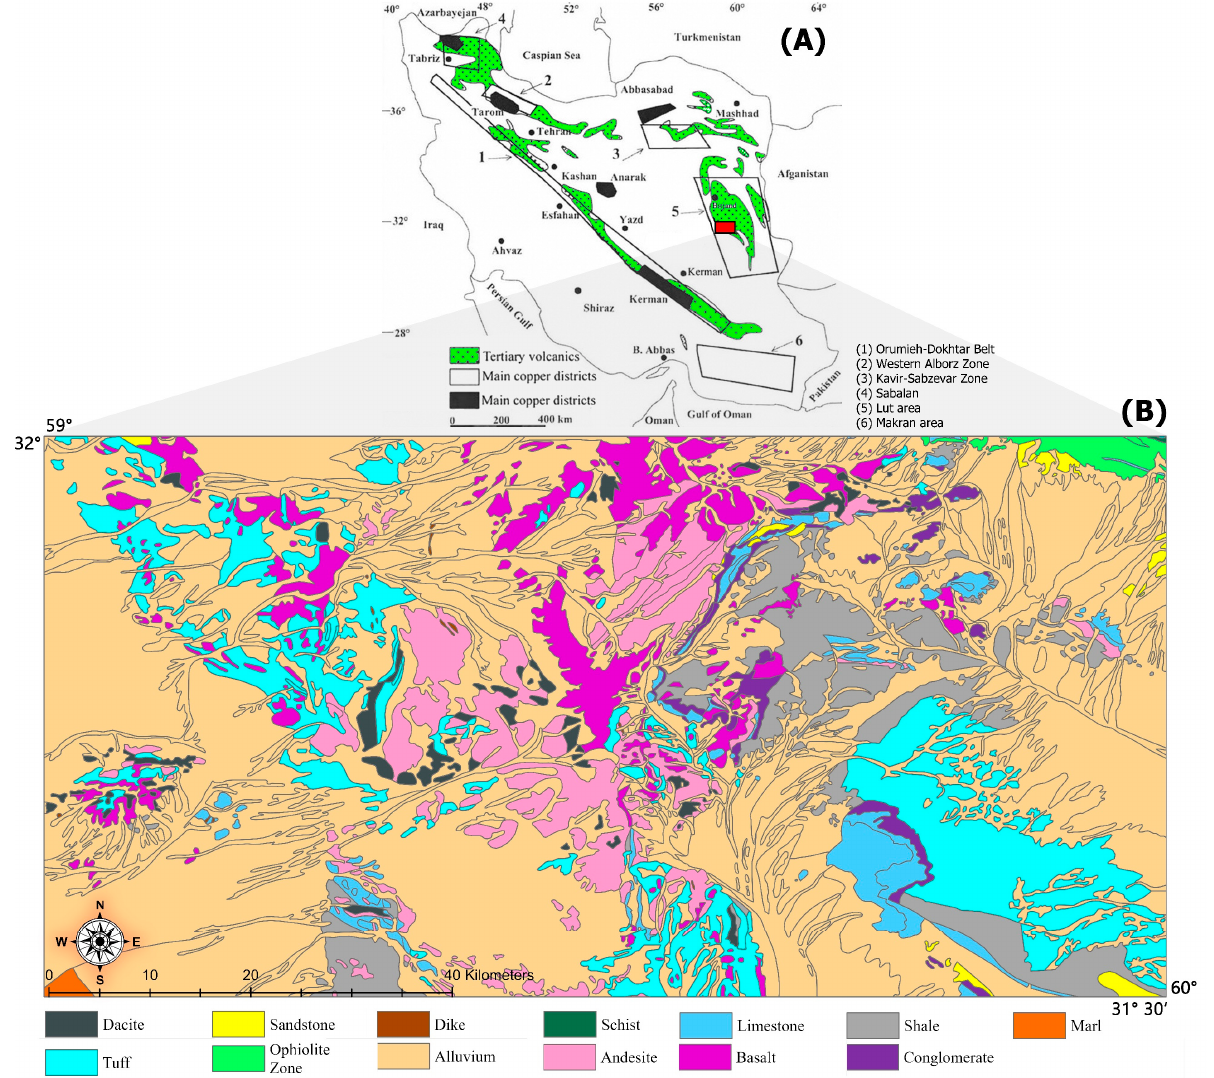
Figure 1. ( A ) Iran Cu mineralization zones and ( B ) study area simplified geological map (Combination of Basiran and Kodegan 1:100.000 geological map) [28,29].